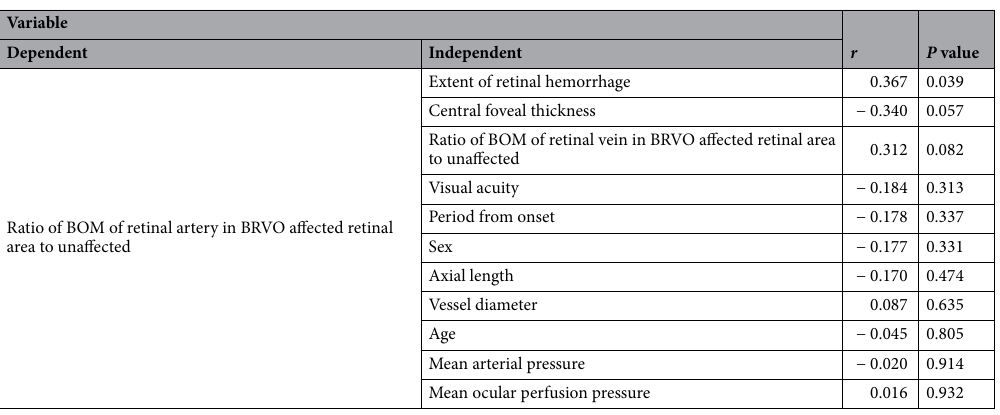
Table 4. Results of Spearman’s rank test analysis.